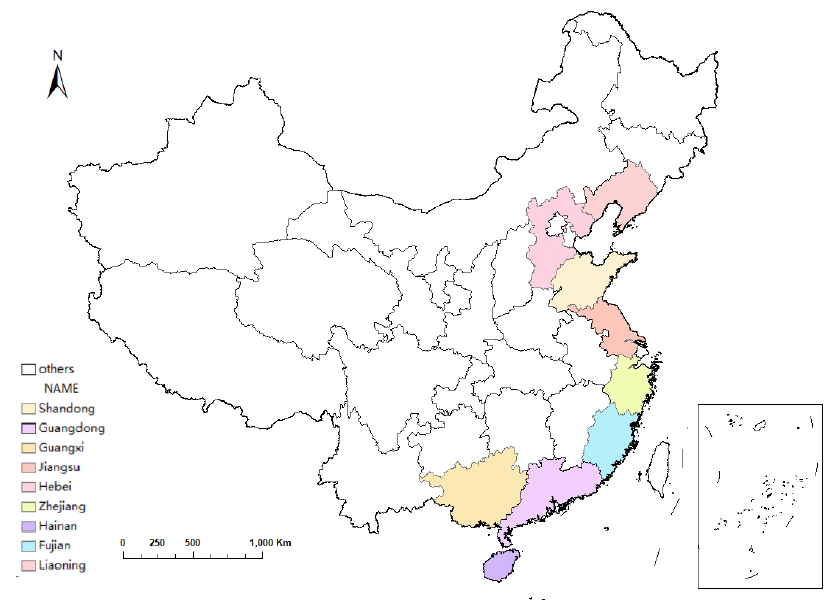
Figure 1. Location of nine provinces of China in 2022.